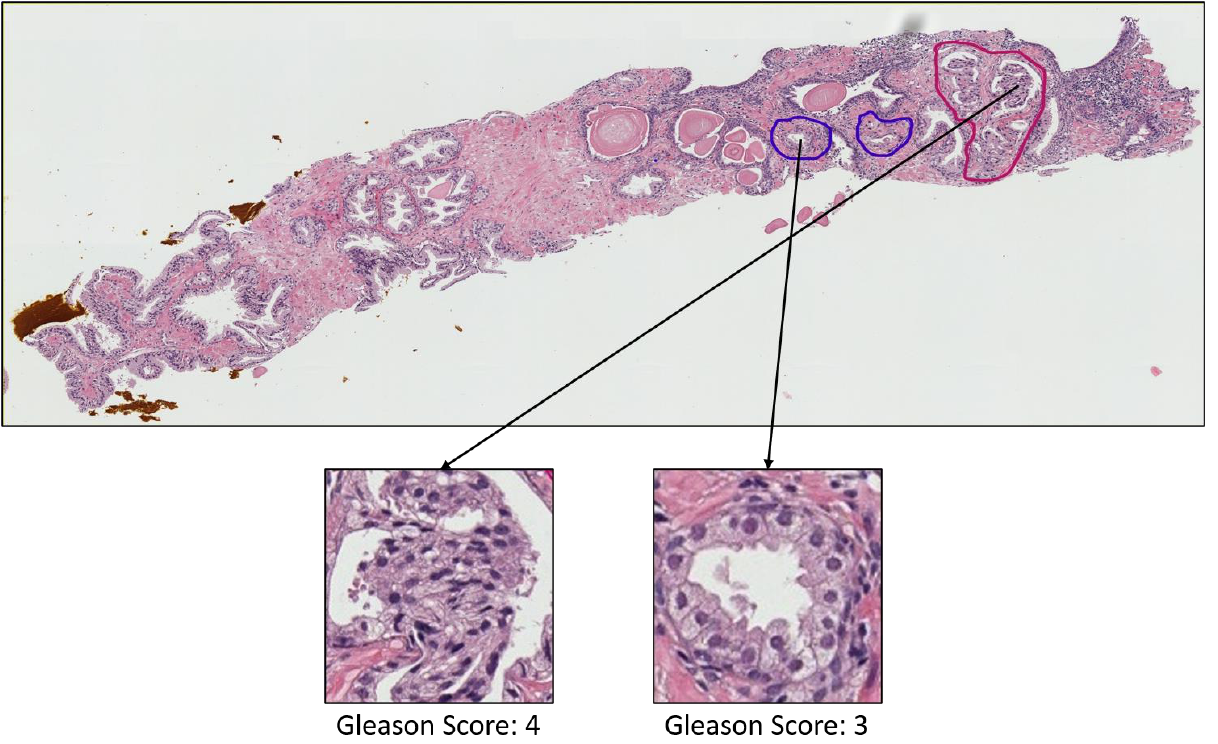
Figure A3. Prostate adenocarcinoma with Gleason scores 5 and 4 annotated with orange and red color, respectively.